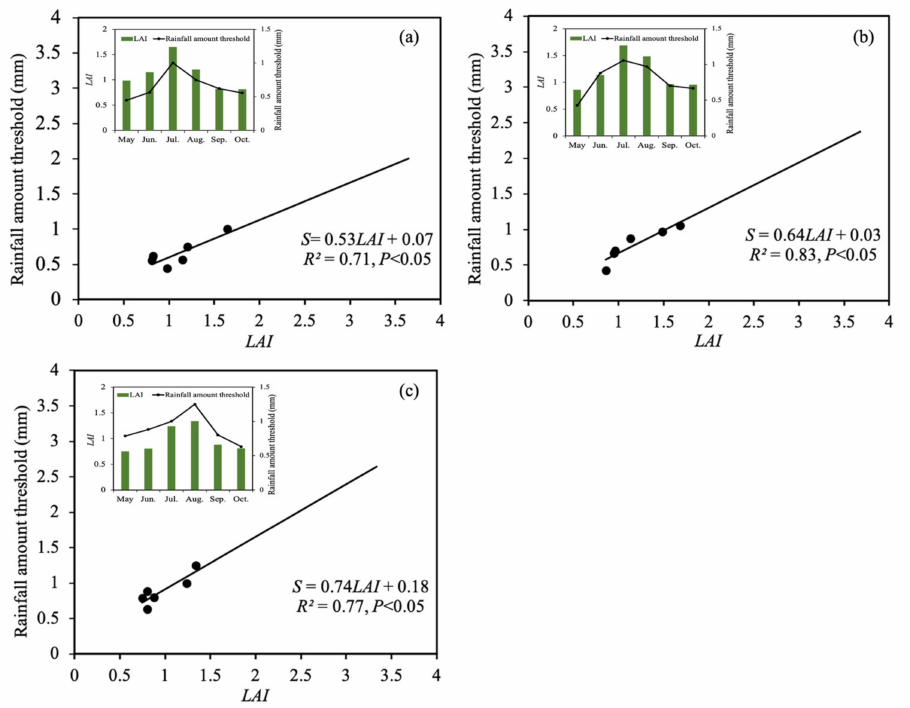
Figure 7. Estimation of rainfall amount threshold ( S ) by leaf area index ( LAI ) at monthly scale in CF ( a ), MF ( b ) BF ( c